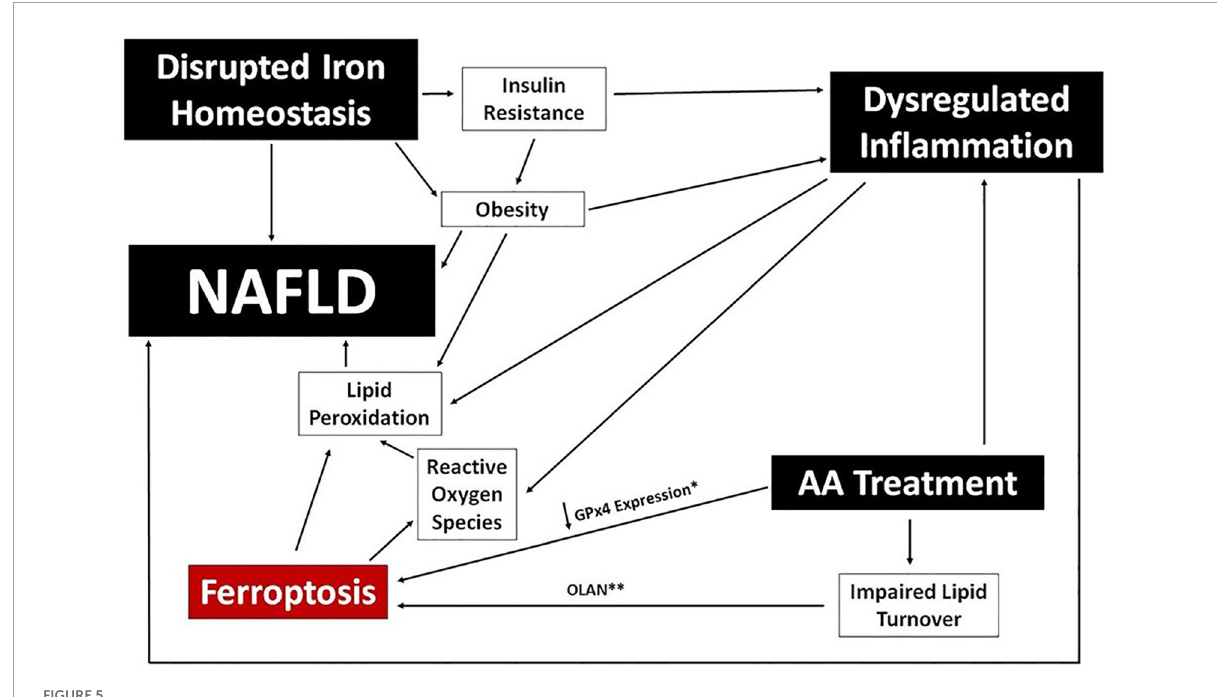
FIGURE5 Ferroptosis and NAFLD in Psychiatric Patients. A potential mechanistic link between ferroptosis and NAFLD is proposed using clinical benchmarks reported in psychiatric patients (black boxes). Specific data points reported for certain AA medications are noted; specifically, downregulation of GPx4 expression ( ∗ ) in human cells following exposure to risperidone, volanaserine, or amisulpride (Malekizadeh et al., 2020) and pathway analysis indicating impaired lipid turnover in the liver of mice treated with olanzapine ( ∗∗ ) (Rostama et al.,